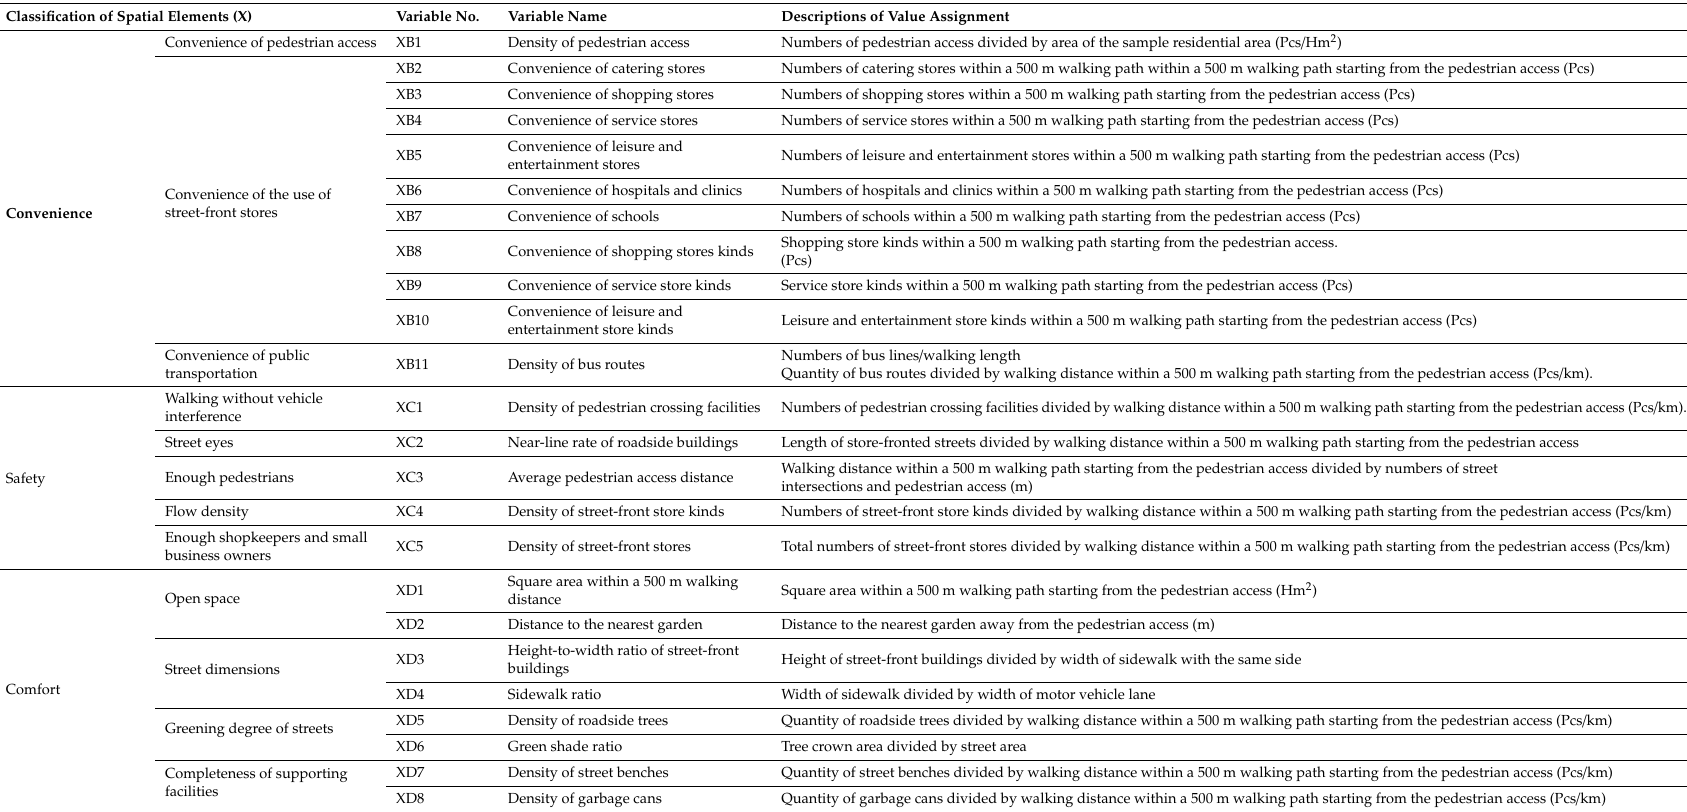
Table A4. Classification and number of spatial elements connected to a health-supportive environment in residential streets.